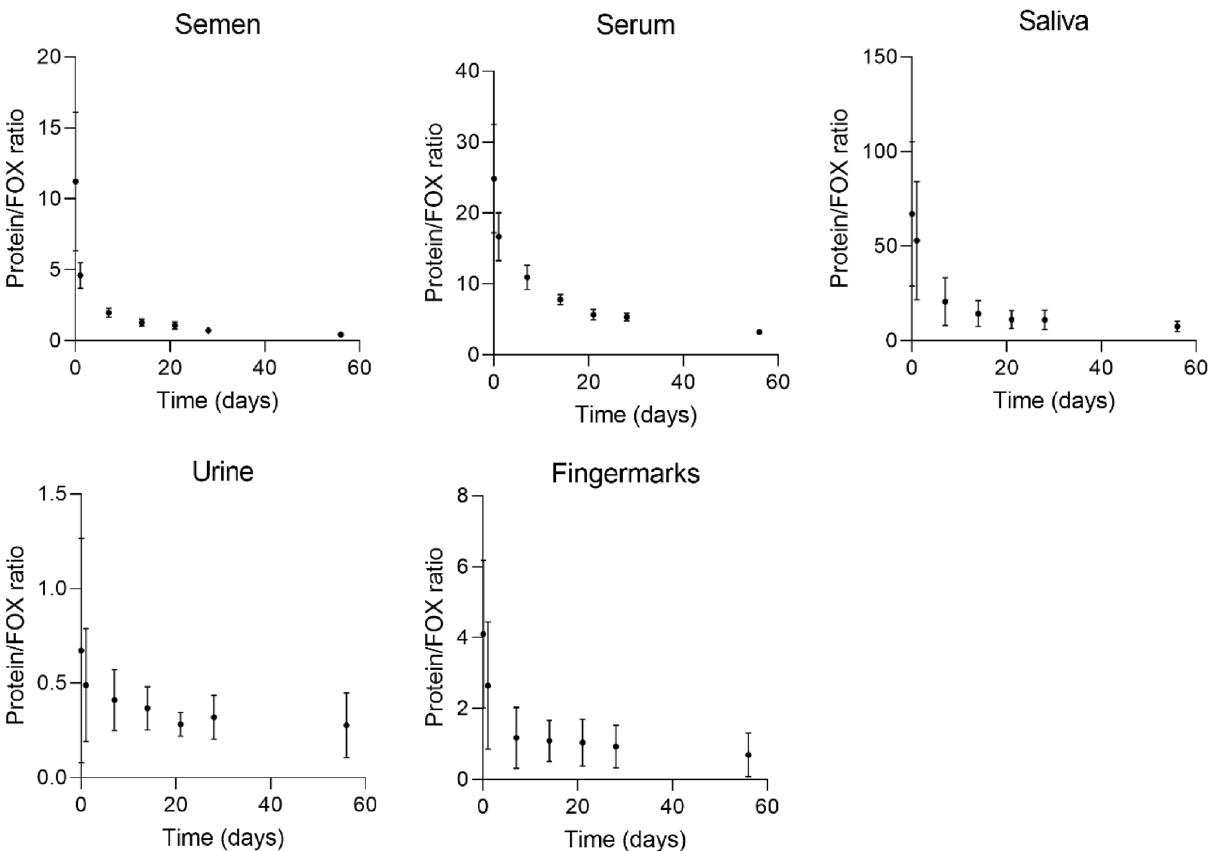
Figure 2. Ageing curves of the five body fluids, including semen, serum, saliva, urine and fingermarks. The ratio of the area under the curves of the Protein fluorescence at excitation 285/ emission 330–400 nm and FOX fluorescence at excitation 365/ emission 400–500 nm were plotted over time. Each dot represents the average ratio from 7 donors and the error bars represent the standard